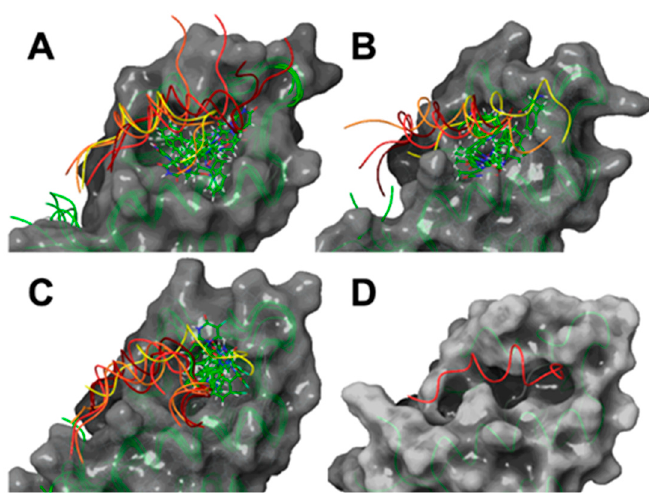
Figure 2. Snapshots from MD simulations. MDM2 in green, p53 from yellow (starting) to dark red (500 ns) containing exo -5b ( A ); endo -5a ( B ); exo -5c ( C ); crystallographic p53-MDM2 complex ( D ).